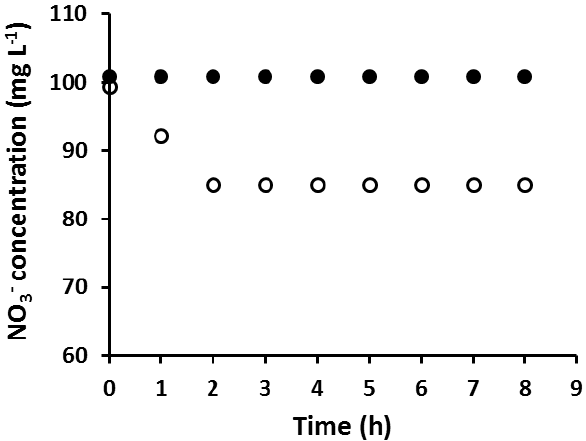
Figure 2. The extraction of NO 3– using an AuNP-coated PIM, fully loaded with Au(III) prior to reduction (●), and using a PIM of the same composition but without AuNPs ( ○ ). Experimental conditions: solution volume and composition: 100 mL, 100 mg·L −1 NO 3− ; PIM mass and composition: 60 ± 3 mg, 20 wt % Aliquat 336, 10 wt % 1-dodecanol (DD) and 70 wt % poly(vinyl chloride) (PVC); shaking rate: 150 rpm. Data points are the average of three extraction experiments with an average standard deviation (SD) of 0.77 mg·L −1 .